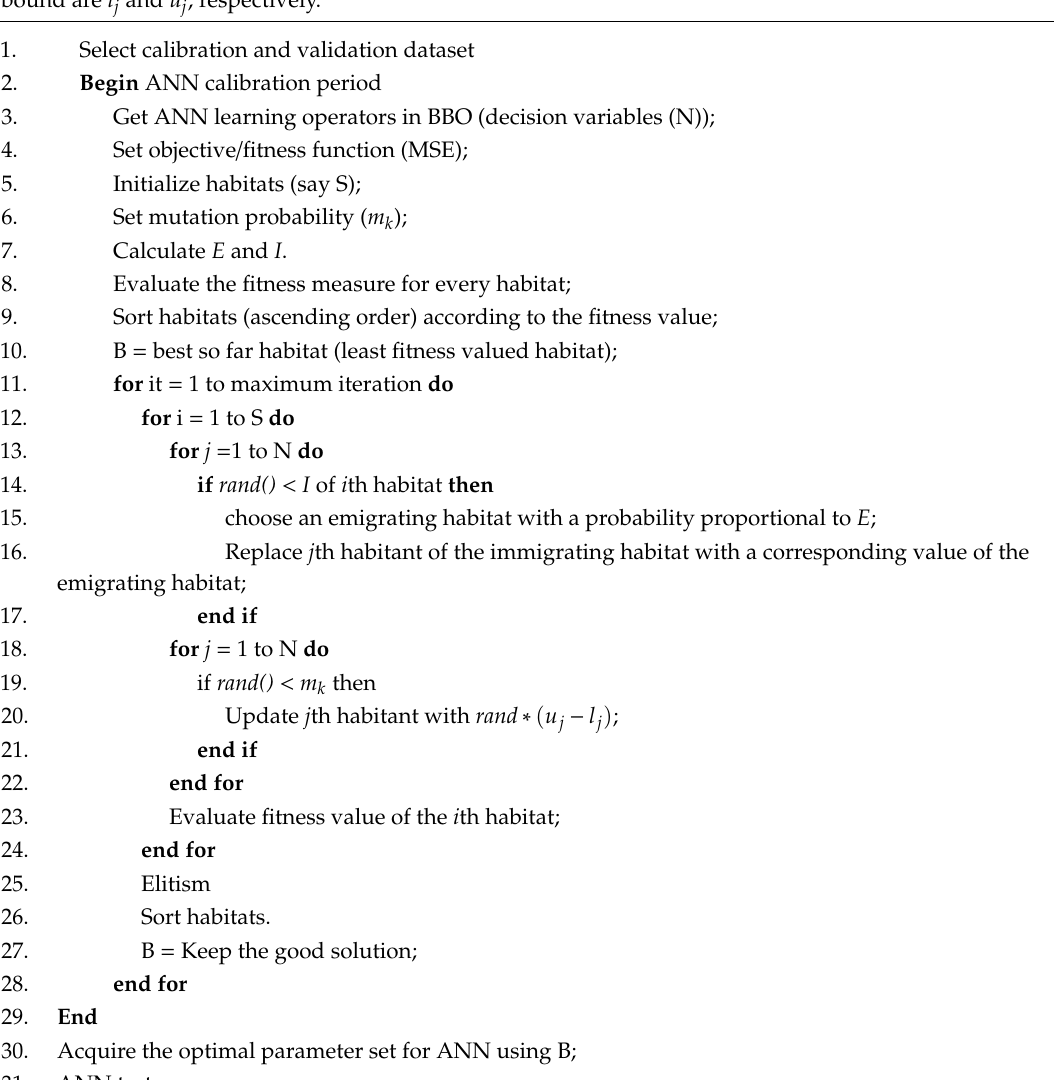
Algorithm 1: Basic structure of the BBO-ANN for prediction of blast-induced ground vibration, rand function produces a random number which is uniformly distributed in [0, 1], the j th dimensional lower and upper bound are l j and u j ,